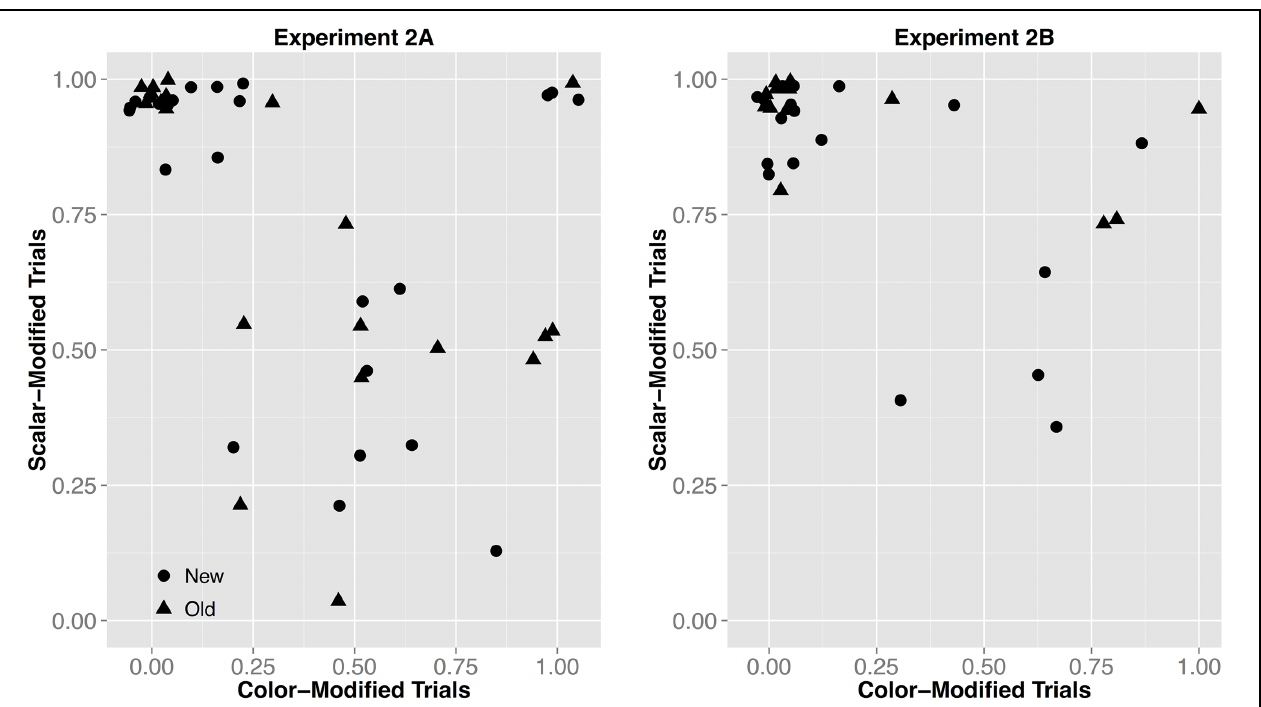
FIGURE 6 | Proportion of responses given for the modifying talker for color- by scalar-modified trials for each individual subject in Experiment 2A and Experiment 2B. Informativity-based generalizations (dots expected to pattern in the top left) are observed when listeners primarily select the modifying talker for the scalar-modified trials (proportion approaching 1.0) and rarely for the color-modified trials (proportion approaching 0.0). Form-based generalizations (dots expected to pattern in the top right) are observed when listeners primarily select the modifying talker for both trials (proportions approaching